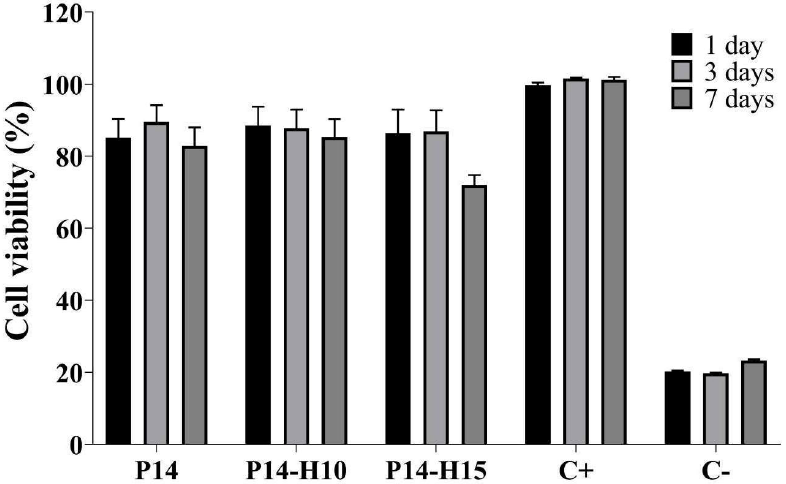
Figure 6. P14, P14-H10 and P14-H15 in vitro cytotoxicity assessment. ( a ) 1 day, ( b ) 3 days, and ( c ) 7 days. Neg: Negative control, fibroblasts cells without testing materials. Pos: Positive control, fibroblasts cells with 20%